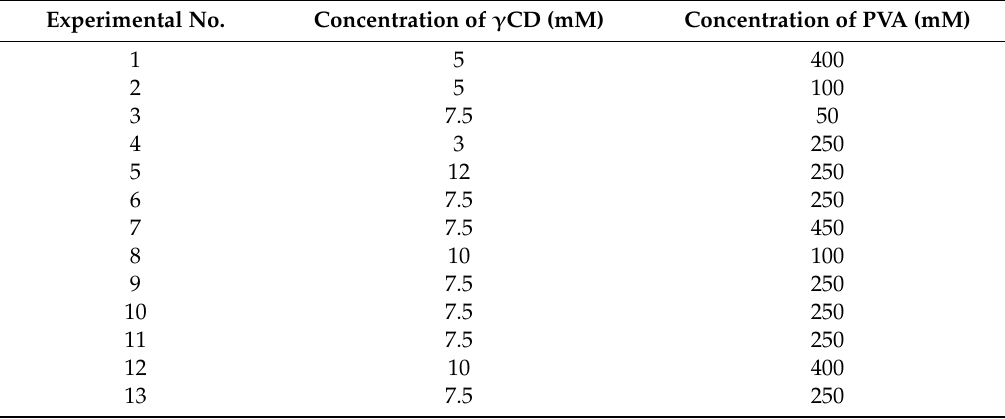
Figure 6. Percentage of inhibition of ascorbic acid in AA/ γ CD ( ) and AA/PVA ( ) complexes. Table 3. Central composite design for AA / γ CD / PVA ternary complexes when concentration of AA was fixed at 0.02 mM. Experimental No.